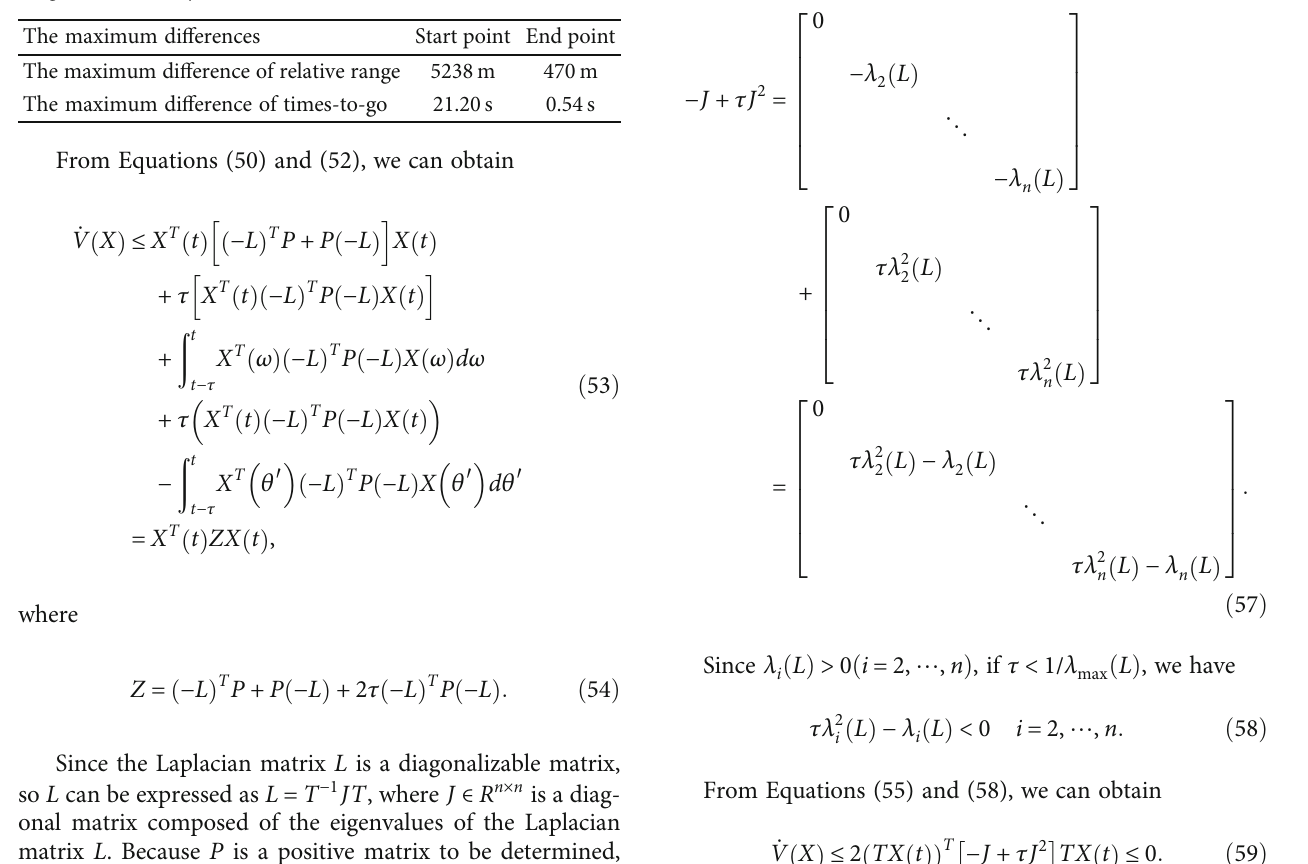
Table 2: Summary of the di ff erences of times-to-go and relative range without